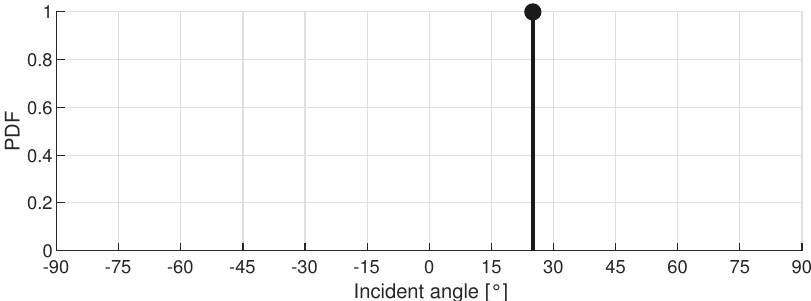
Figure 1. Example of an f LOS , i -PDF with incident angle 26° stored in the reference dataset T